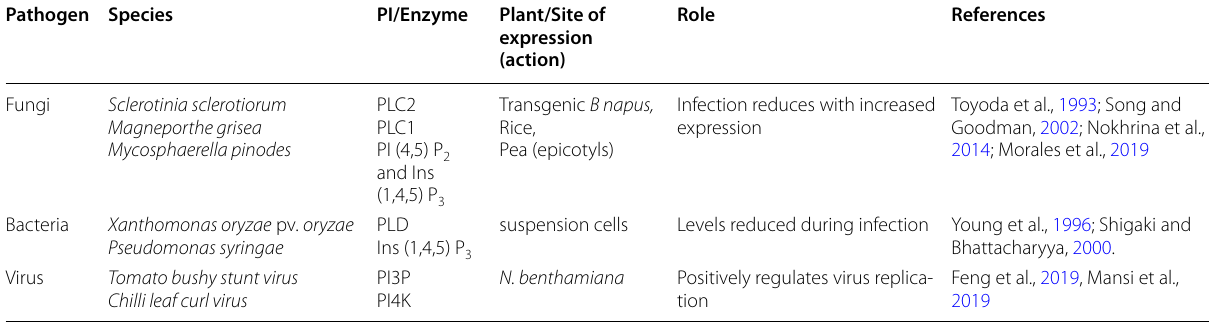
Table 2 Role of phosphoinositides in biotic stress Pathogen